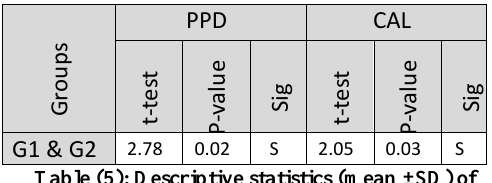
Table (4): Inter group comparison of mean of PPD and CAL between G1 & G2.